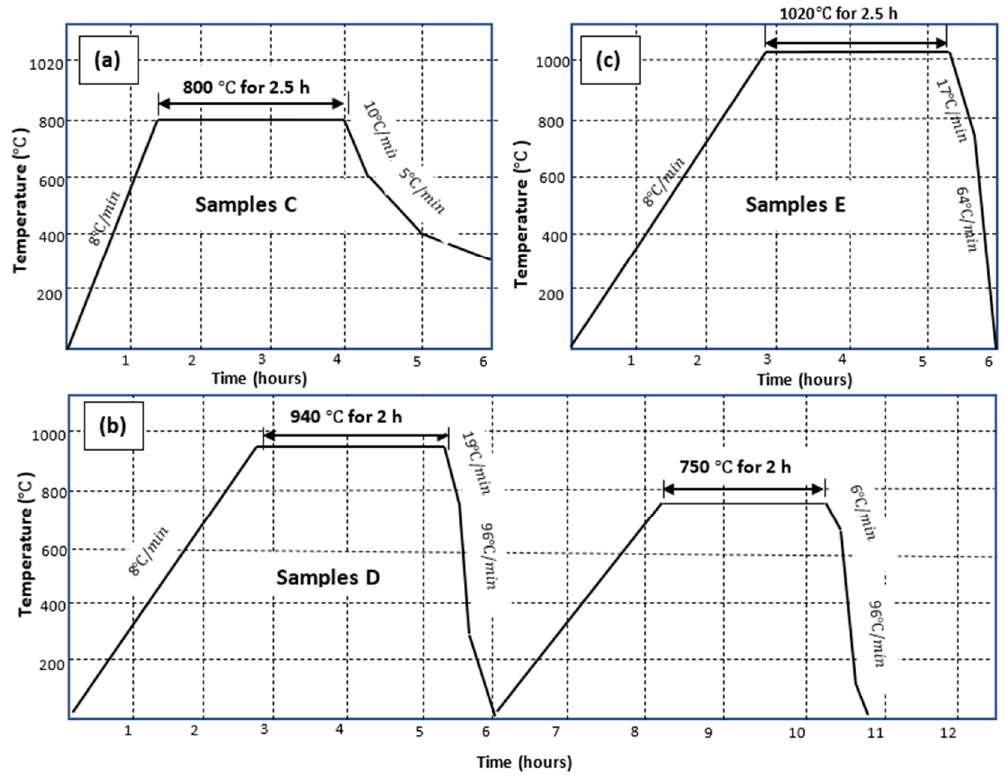
Figure 2. Heat treatment cycles for high temperature annealed DMLS Ti6Al4V (ELI) for ( a ) samples C, ( b ) samples D and ( c ) samples E, following initial stress relieving heat treatment.